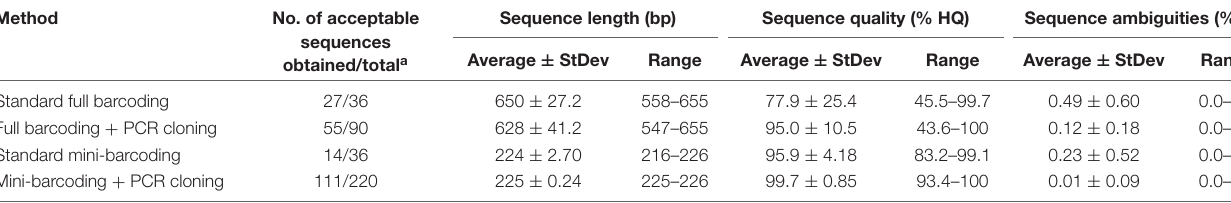
TABLE 3 | Sequencing results of methods assessed for sequencing parameters and quality